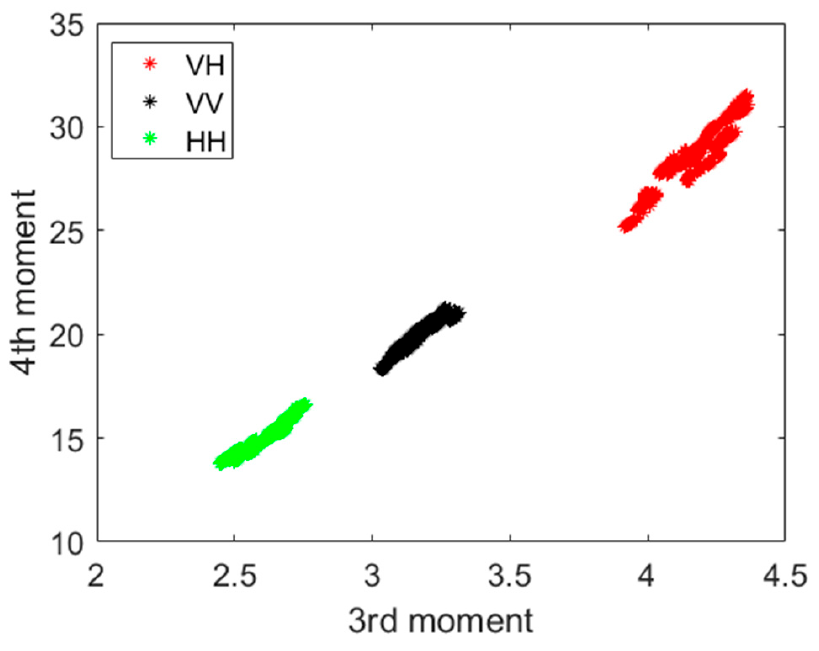
Figure 14. Statistical feature distribution of echo signals in three polarization modes for the non-motor vehicle.